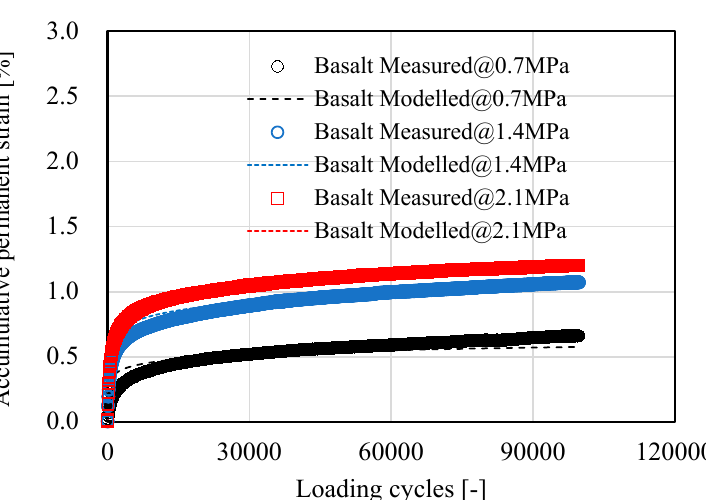
Figure 7. Development of resilient modulus of basalt aggregate under cyclic loading.